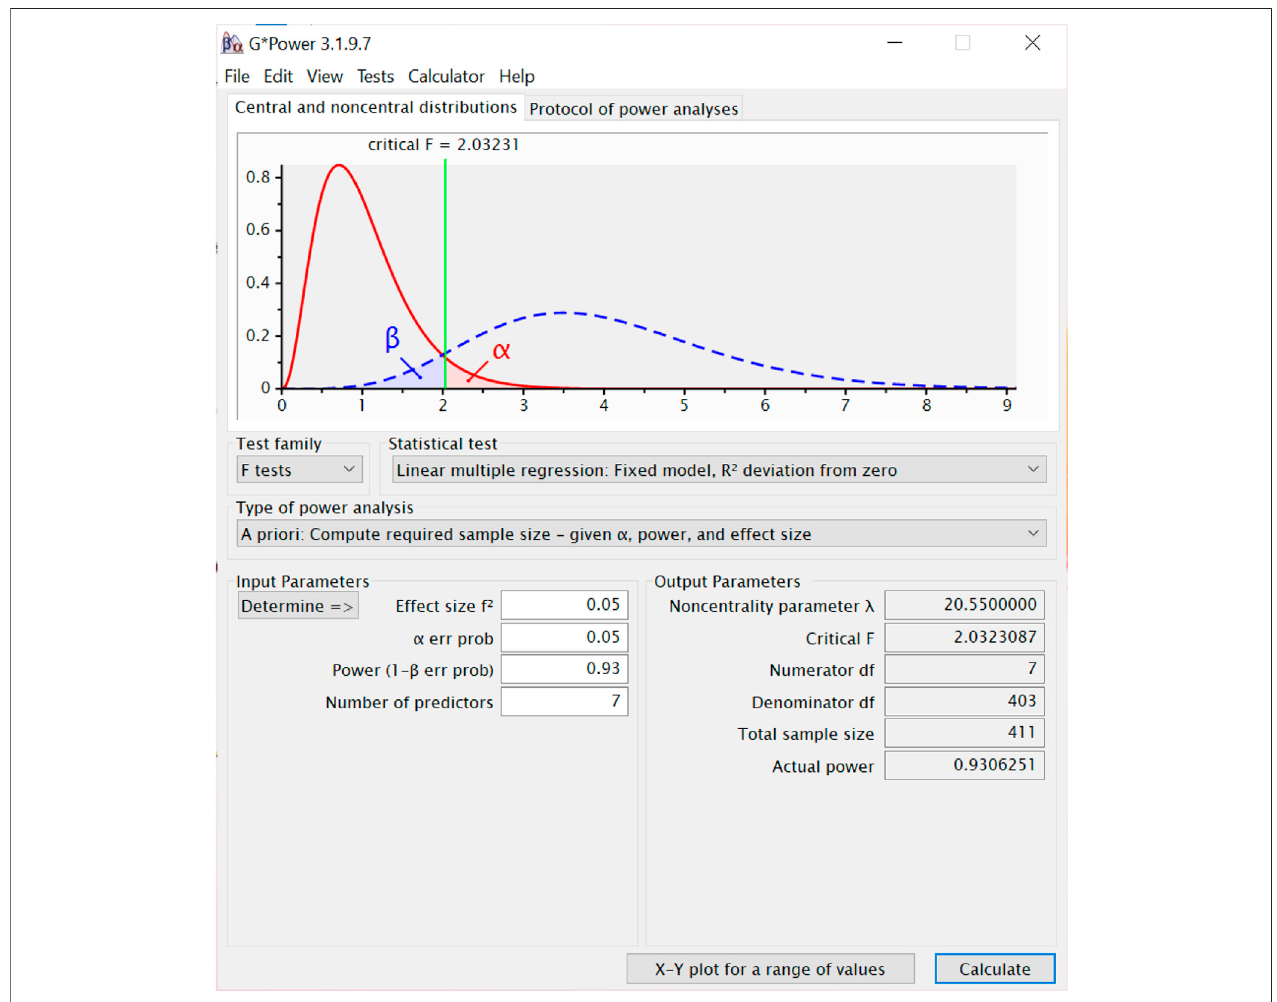
FIGURE 1 | Central and Noncentral